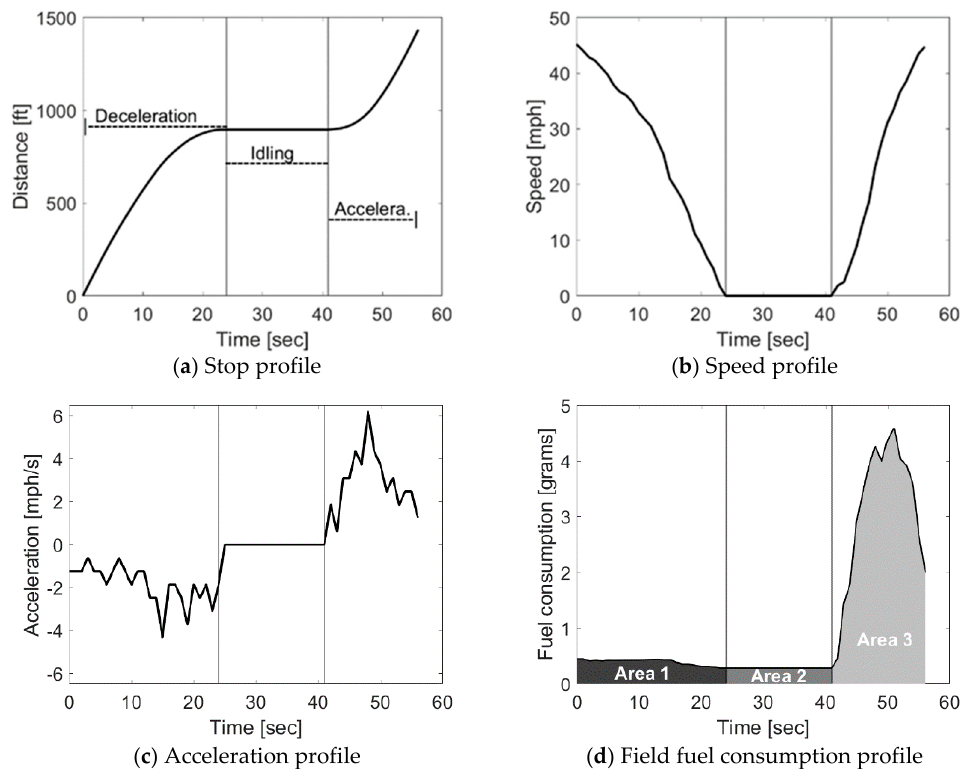
Figure 1. Dynamics and kinematics of a stopped vehicle